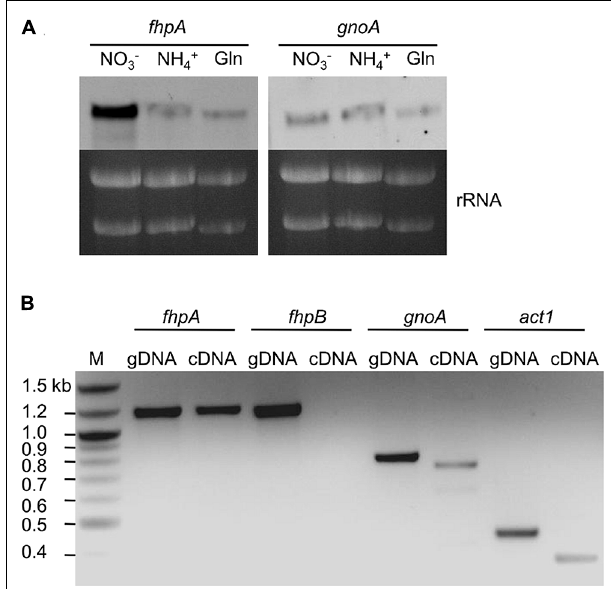
FIGURE 3 |Transcription of genes involved in RNI detoxification. (A) Northern blot analysis of fhpA and gnoA mRNA steady state levels in A. fumigatus cultivated for 16 h in AMM with different nitrogen sources. Gln, glutamine; rRNA was used as loading control. (B) PCR on cDNA of lungs of mice infected with A. fumigatus . Immunosuppressed mice were infected with A. fumigatus wild-type conidia and sacrificed at day 5 post infection. Genomic DNA (gDNA) of A. fumigatus was used as control template and transcription of the gene encoding A. fumigatus actin ( act1 ) was used as positive